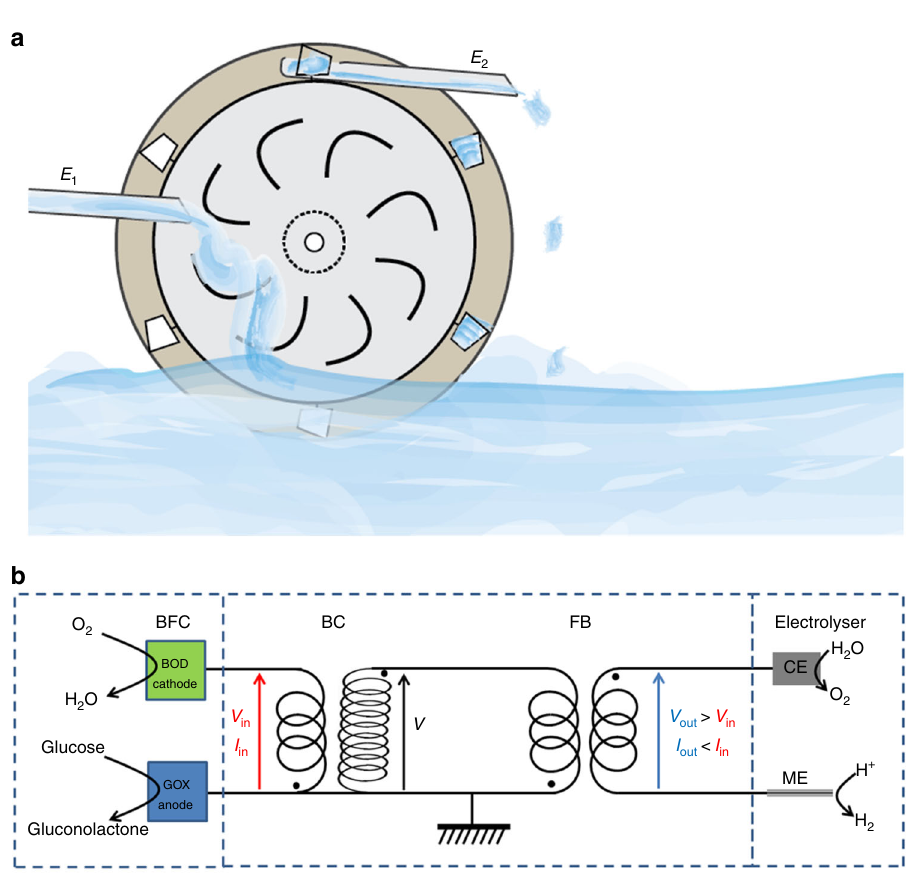
Fig. 2 Principle of power conversion. a The concept of the uphill reaction scheme can be illustrated by a water wheel. A continuous water fl ux from the left at an energy level E 1 can turn a paddle wheel, which periodically lifts a smaller water volume to a higher energy level E 2 on the right . b This principle is applied to the redox reactions of this work where the energy provided by the oxidation of several glucose molecules in a biofuel cell (BFC) powers an electronic circuit that fi rst raises the potential (voltage) in a boost-converter (BC), followed by a fl yback (FB) that electrically isolates the electrolyser (on the right) from the input. The electrolyser is composed of a microelectrode (ME) and a counter electrode (CE). Power conversion and transfer steps are only depicted by transformers, whereas switches and recti fi ers are omitted for simplicity. It is important to note that the reaction proceeds in a single vessel and that no external energy is provided. This results in the production of dihydrogen from proton reduction in the same solution as the glucose oxidation, the latter providing the overall driving